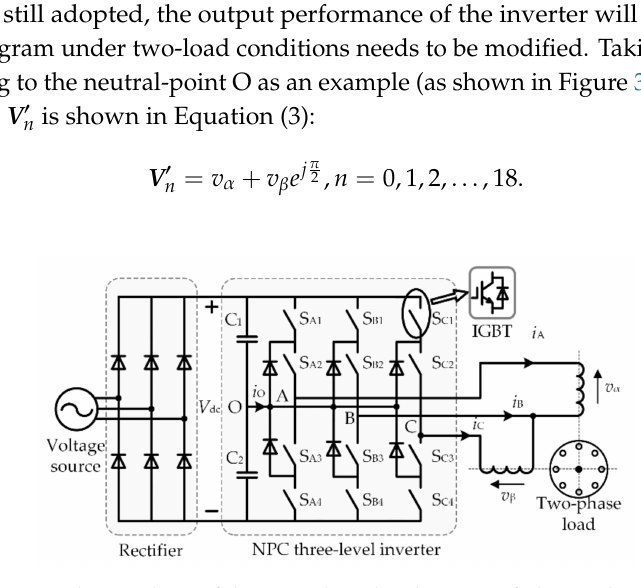
Figure 3. The topology of the NPC three-level inverter fed two-phase